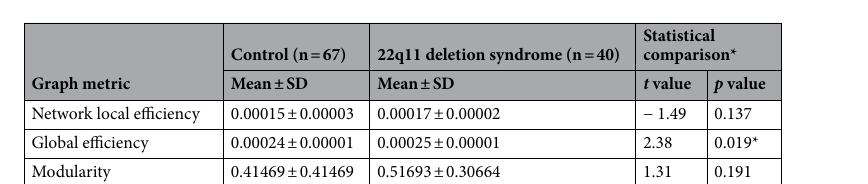
Table 2. Group comparisons of global graph metrics in networks of 22q11 deletion syndrome patients and healthy controls *Covarying for age, gender, history of psychosis and mean FD.